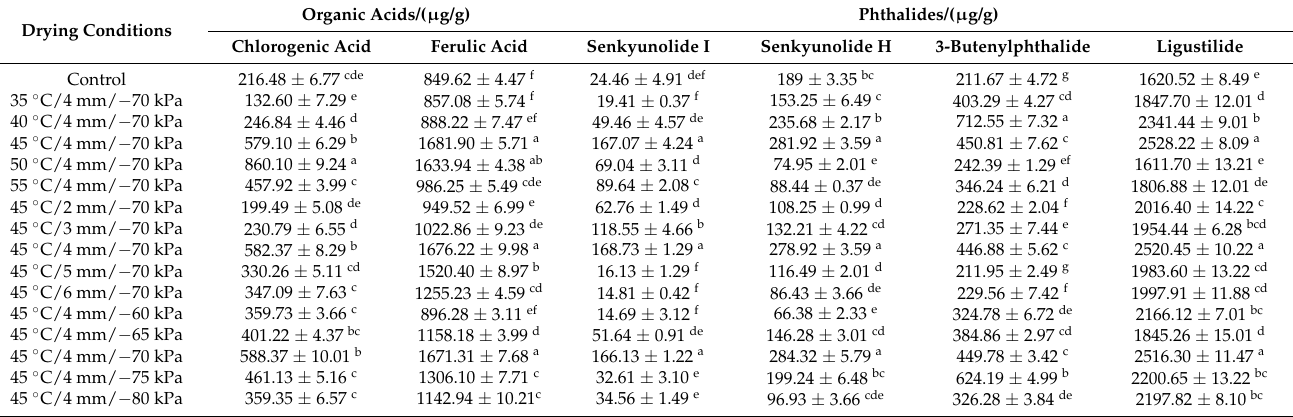
Table 3. The content of natural active ingredients in Angelica sinensis dried before and after microwave vacuum drying.